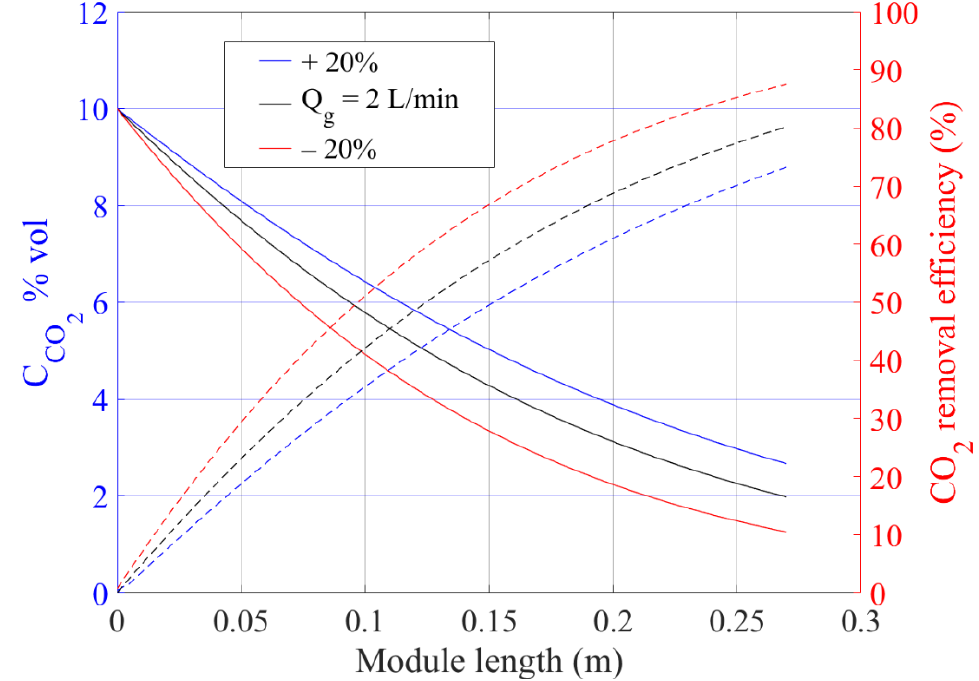
Figure 14. CO 2 concentration in gas (on the left, represented by solid lines) and CO 2 removal efficiency (on the right, represented by the dashed lines) over the module length (increase/decrease scenarios of gas flow rate).